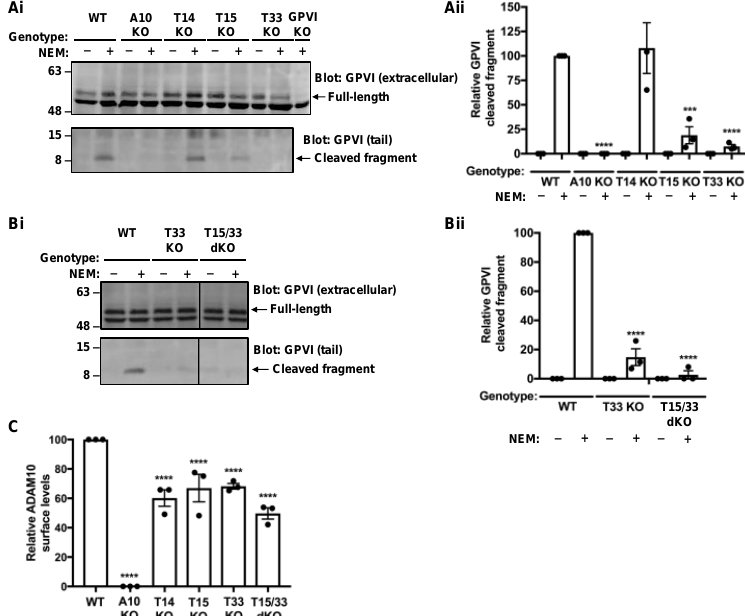
Figure 2. Tspan15 and Tspan33 are required for cleavage of endogenous GPVI in HEL cells. ( Ai ) Wild-type (WT), ADAM10-knockout (A10 KO), Tspan14-knockout (T14 KO), Tspan15-knockout (T15 KO), Tspan33-knockout (T33 KO) and GPVI-knockout (GPVI KO) HEL cells were treated with 6.2 ng/mL PMA for 72 h. Cells were stimulated with 2 mM NEM (+) for 1 h before harvest. Cells were lysed in 1% Triton X-100 and separated by SDS-PAGE. Lysates were probed with a mouse anti-human GPVI antibody (11A7), which recognises the extracellular region of GPVI and therefore only the full-length protein (top panel) and a rabbit anti-human GPVI antibody, which recognises the cytoplasmic tail of GPVI (bottom panel). ( Aii ) Relative GPVI cleavage was calculated by normalising the cleaved fragment signal to the full-length GPVI; the NEM-treated WT was arbitrarily set at 100. Error bars represent the standard error of the mean from three independent experiments. Data were normalised by arcsine transformation and statistically analyzed using a two-way ANOVA followed by a Bonferroni multiple comparison test, compared to WT (***, p < 0.001; ****, p < 0.0001). ( Bi ) WT, T33 KO and Tspan15/33 double knockout (T15/33 dKO) HEL cells were treated with PMA and subjected to lysis and Western blotting as described in panel ( Ai ). ( Bii ) Relative GPVI cleaved was quantitated and statistically analyzed as described in panel ( Aii ). ( C ) ADAM10 surface expression on PMA-differentiated cells used in panels A and B were analyzed by flow cytometry and quantitated as described in Figure 1B. The data shown are from single CRISPR/Cas9 knockout clones, but similar data were generated using a second set of clones generated using different guide RNA sequences (data not